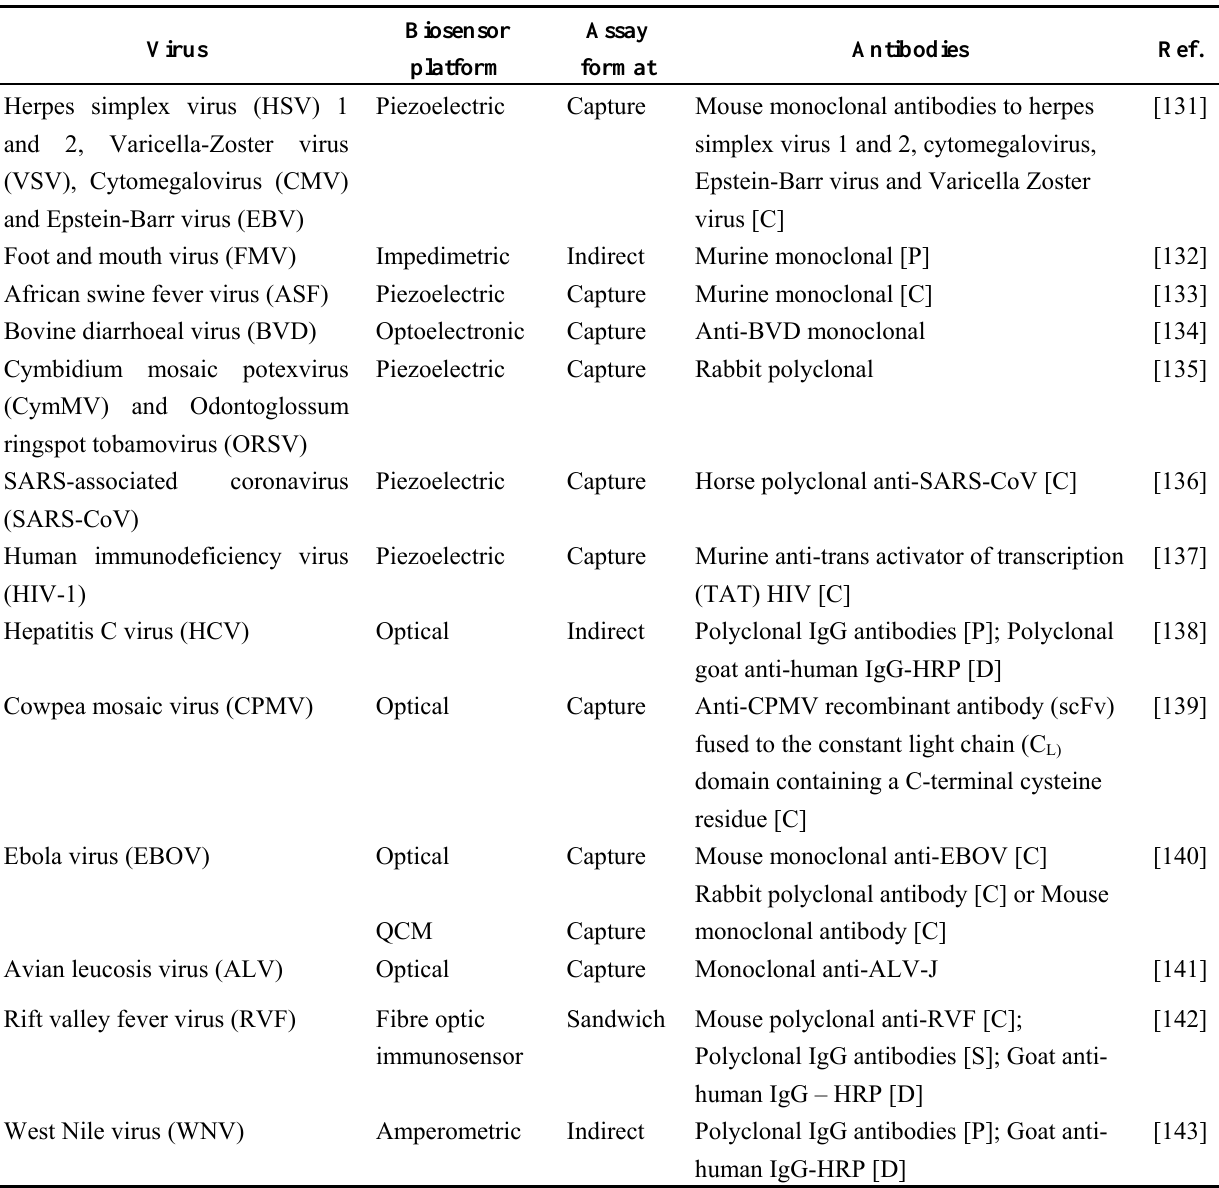
Table 5. A selection of immunosensor-based assays for viral pathogen detection. Key: [C] - capture antibody; [P] - primary antibody; [S] - secondary antibody; [D] - detection antibody. Where primary antibodies are used, the antigen/epitope is immobilised on the sensor surface.